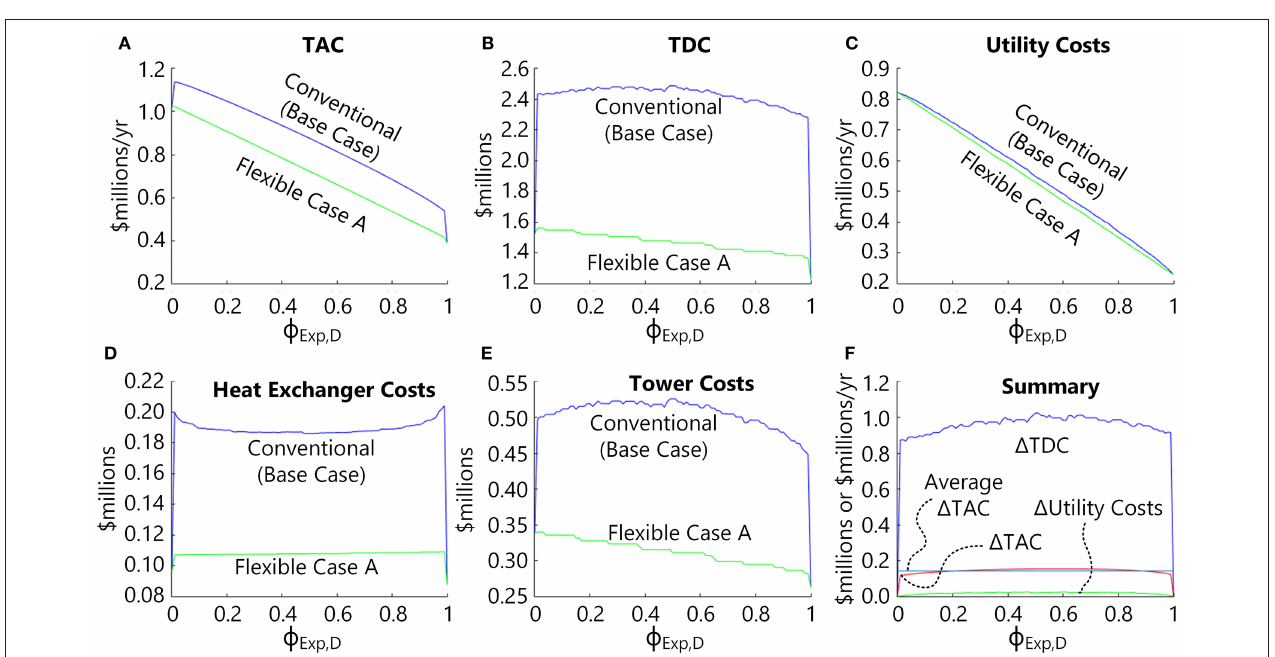
FIGURE 6 | Optimization results for Problem 2 for Flexible Case A as a function of φ Exp , D compared against the optimal Base Case results (see Figure 4 ). (A) The expected TAC for the Base Case and Case A ( TAC BaseCase , Exp and TAC CaseA , Exp ). (B) The total direct costs for the Base Case ( TDC C 1 + ... + TDC C 4 ) and Case A ( TDC A 1 + TDC A 2 ). (C) The expected annual utility costs for the Base Case ( AOC C 1, Exp + ... + AOC C 4, Exp ) and for (Case A AOC A 1, Exp + AOC A 2, Exp ). (D) The total distillation column costs for the two cases, (E) the total heat exchanger capital costs for the two cases, and (F) the cost difference of the Base Case minus Case A for the utilities (green line), total annualized costs (red line), and total direct costs (blue). The average of the cost difference for TAC (cyan line) is shown to better see the curvature of the red line.